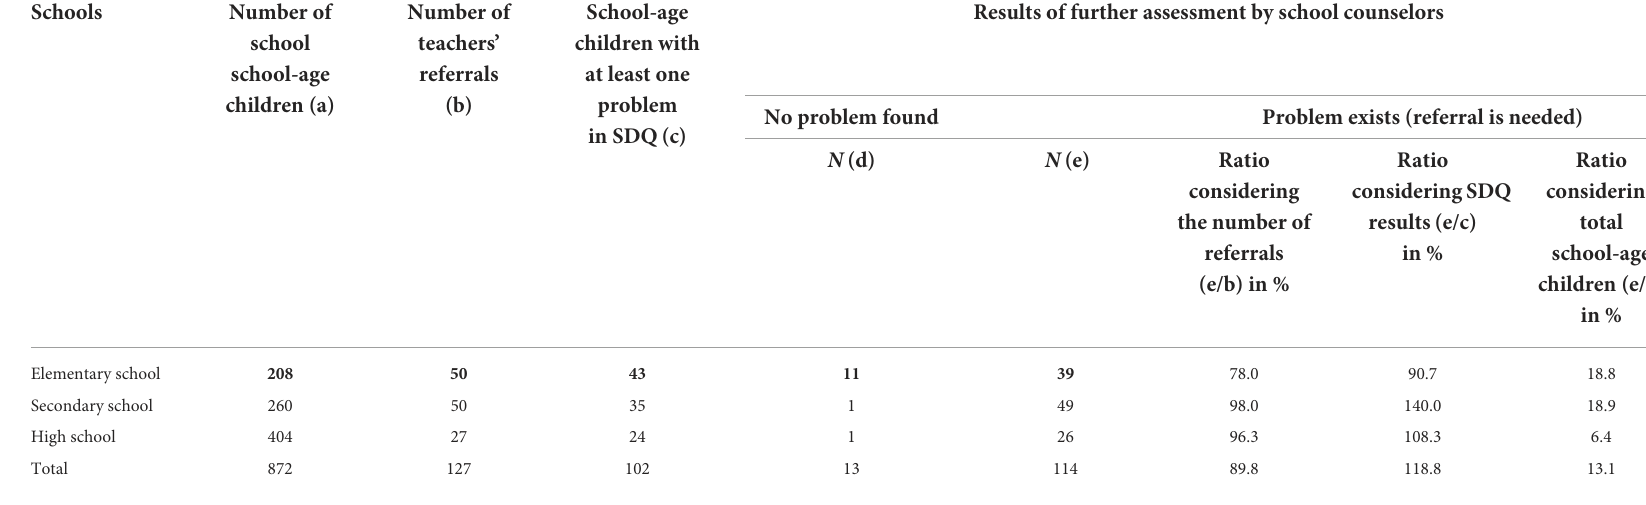
TABLE 3 Results of further mental assessment performed by school counselors on school-age children referred to them by school